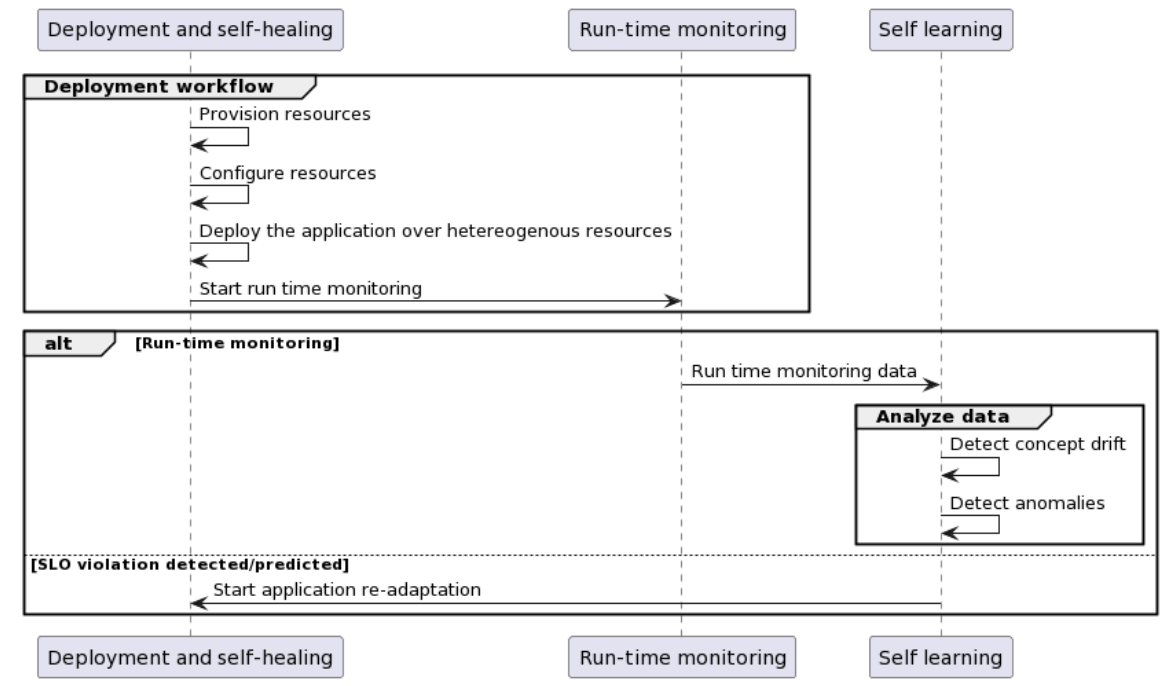
Figure 4. Sequence diagram of the proposed Cloud Ops Optimizer workflow through the reference framework.